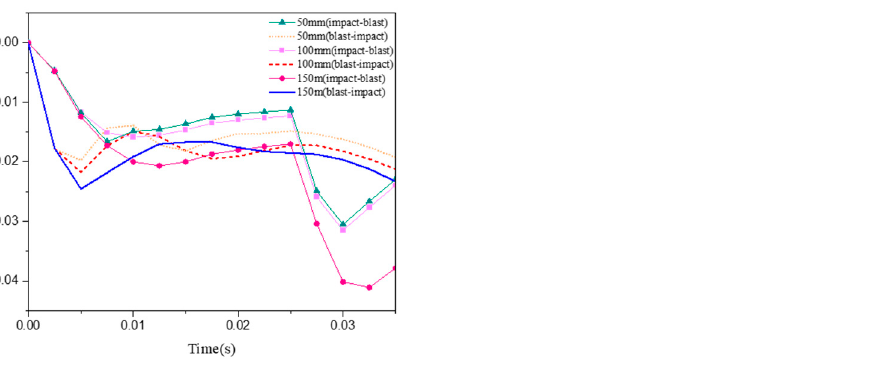
Figure 15. Damage states of beams under combined loads of different transverse reinforcement spacing.